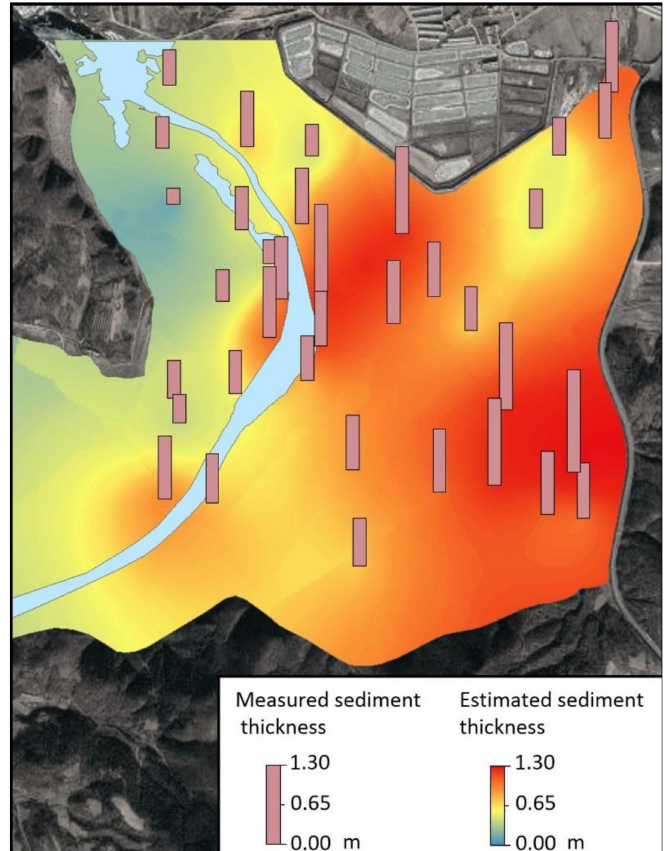
Figure 3. Sediment thickness in